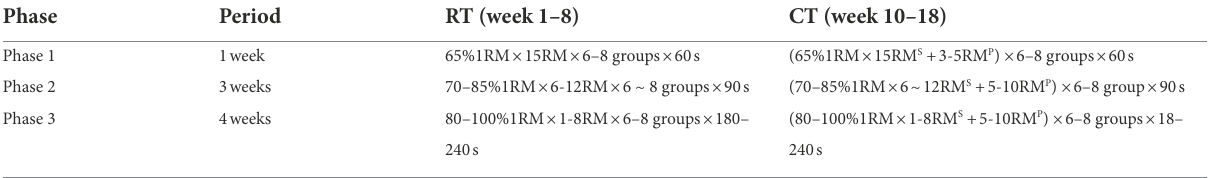
TABLE 2 Resistance training and plyometric training program.